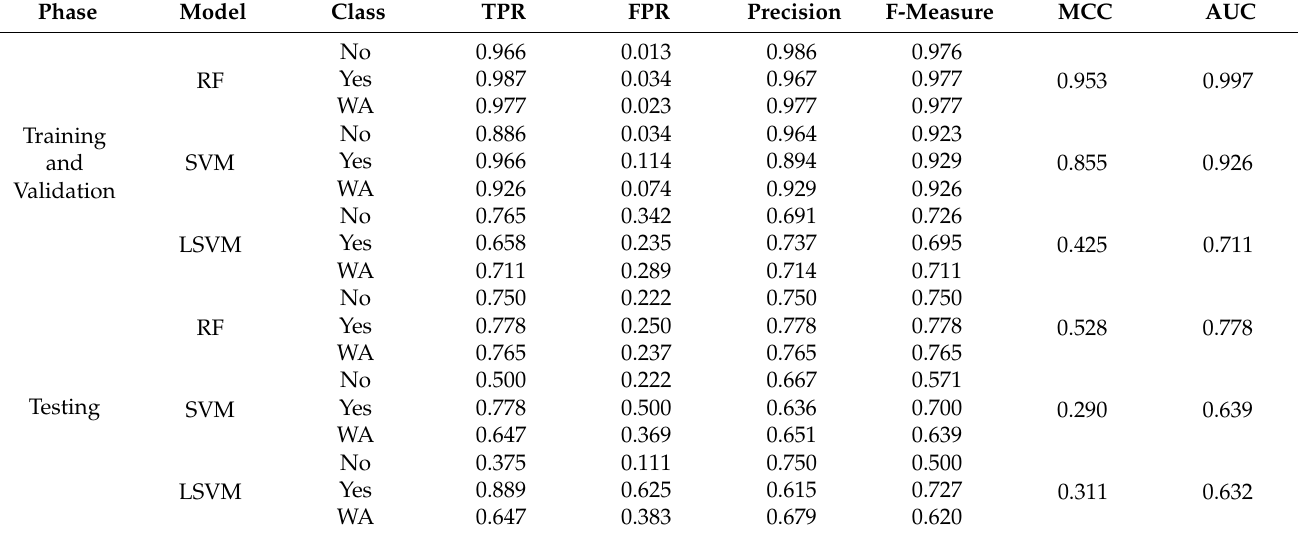
Table 10. Comparison of the results from different models on periglacial debris flow